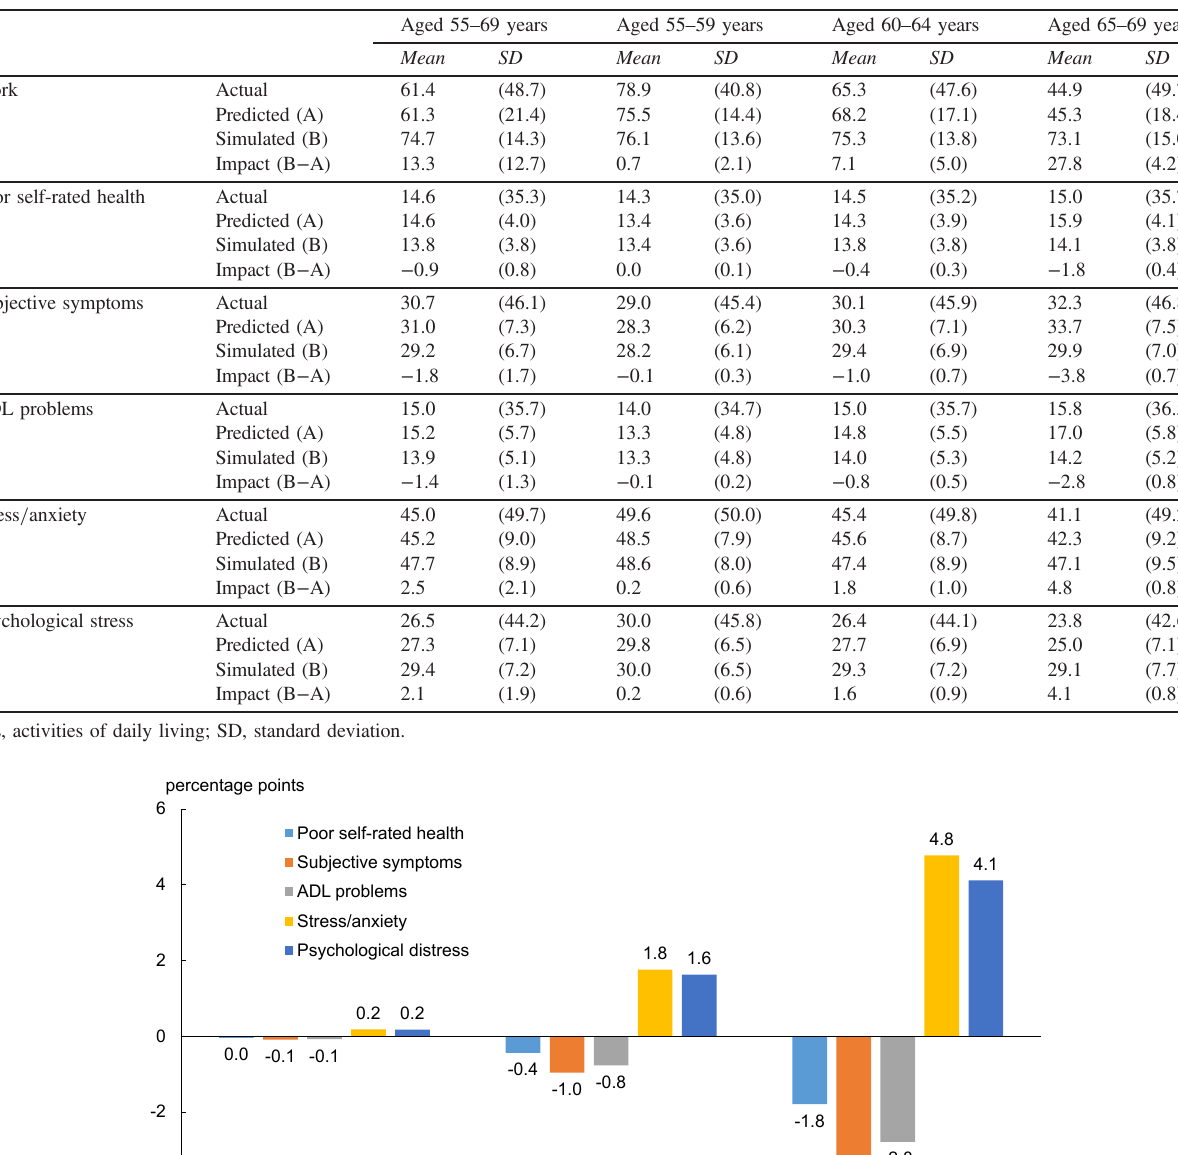
Table 5. Simulated impacts on employment and health outcomes of raising mandatory retirement and public pension eligibility ages to 70